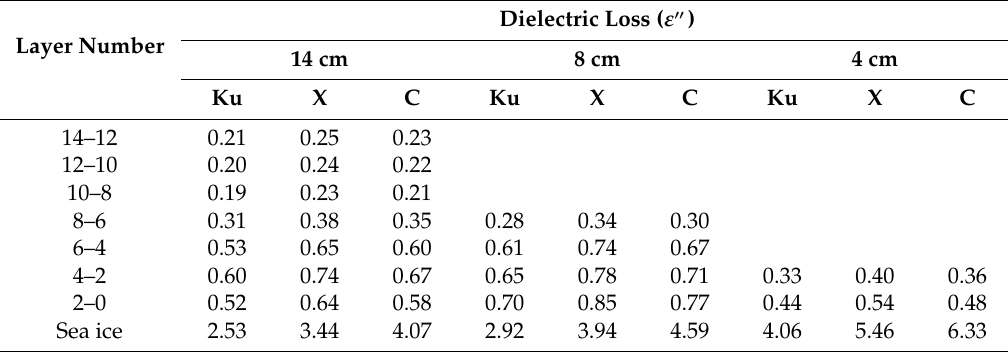
Table 6. Modeled multi-layer snow dielectric loss ( ε (cid:48)(cid:48) ) for the 14 cm, 8 cm and 4 cm snow covers on smooth FYI, for Ku-, X- and